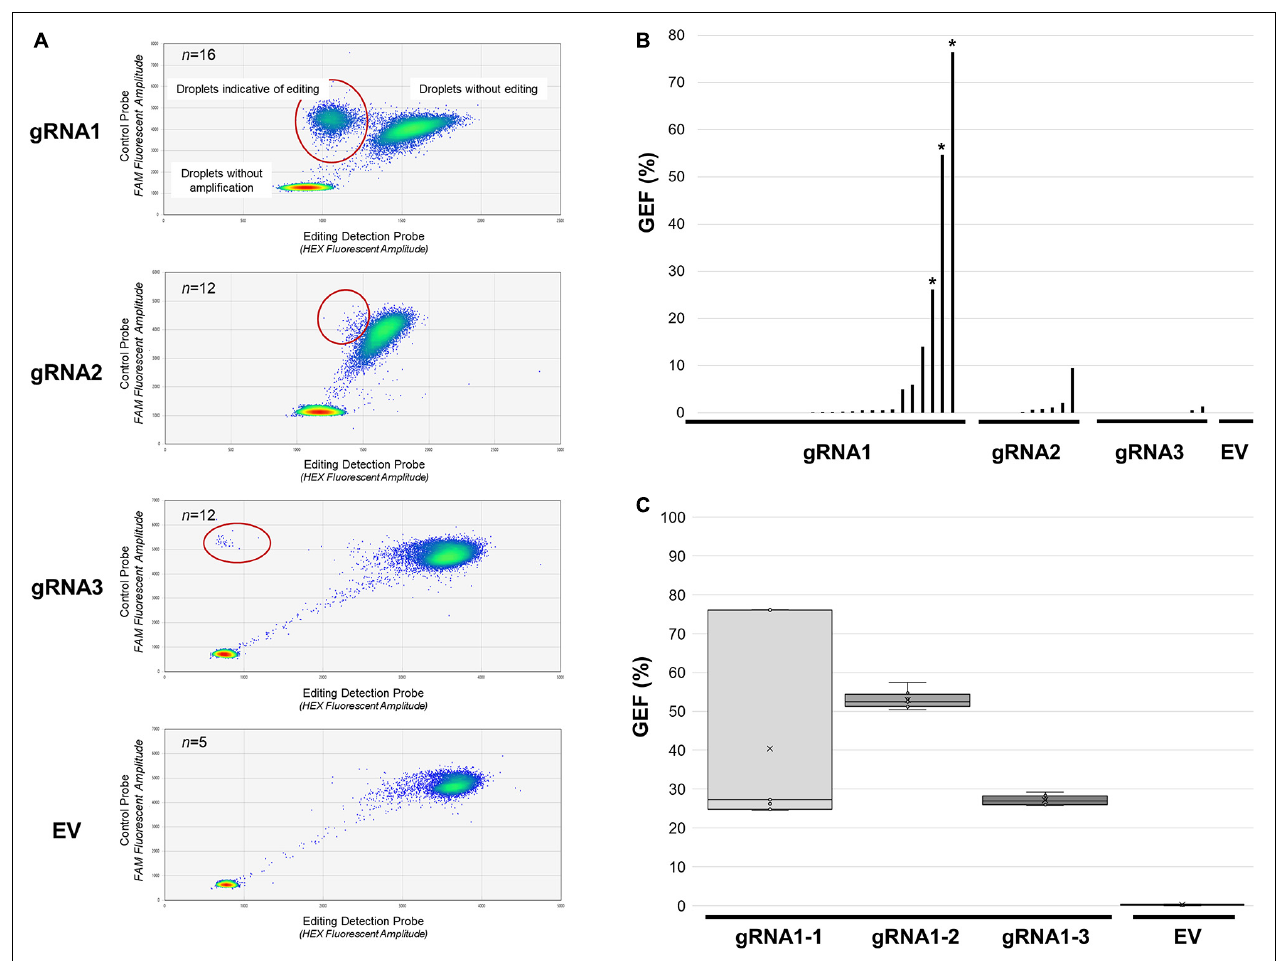
FIGURE 2 | Assessment of MsSPL8 editing frequencies in transgenic plants using GEF-ddPCR. (A) FAM (control probe) and HEX (editing probe) fluorescence following GEF-ddPCR of SPL8-gRNA transgenic genotypes, as well as a selection of EV controls. Heat maps indicate droplets that were not amplified, as well as those that bound both probes (not edited) and those that only bound the control probe (potentially edited, circled in red). (B) GEF of each transgenic genotype assessed using GEF-ddPCR. Asterisks denote genotypes that were selected for screening of separate branches [shown in panel (C) ]. (C) Evaluation of GEF in eight distinct branches from three independent edited SPL8-gRNA1 genotypes, as well as EV controls. Blocks represent the upper and lower quartiles of the values obtained, x denotes median values, and bars indicate maximum and minimum values. EV, empty vector controls, gRNA1, SPL8-gRNA1 genotypes, gRNA2, SPL8-gRNA2 genotypes, gRNA3, SPL8-gRNA3